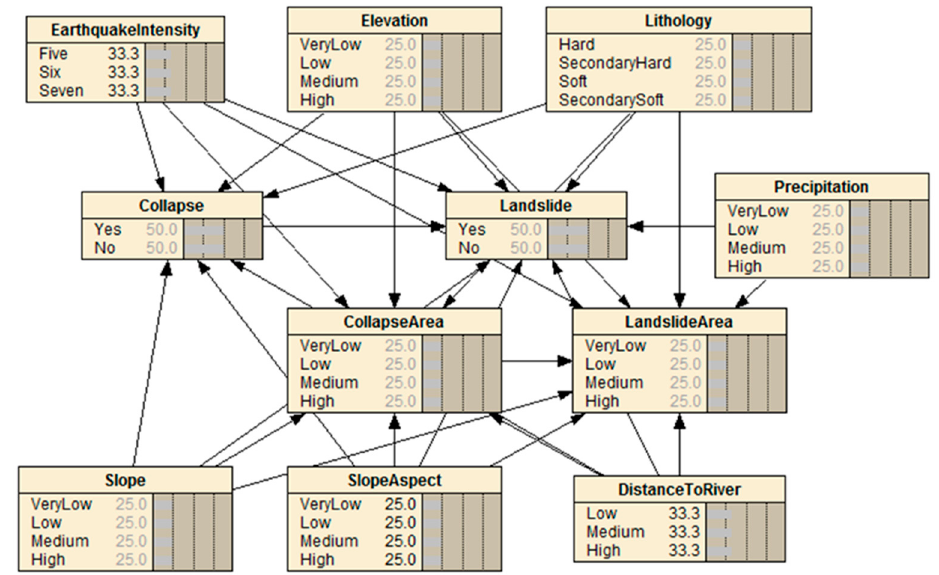
Figure 2. The Bayesian network structure of the Changbai Mountain earthquake disaster chain.